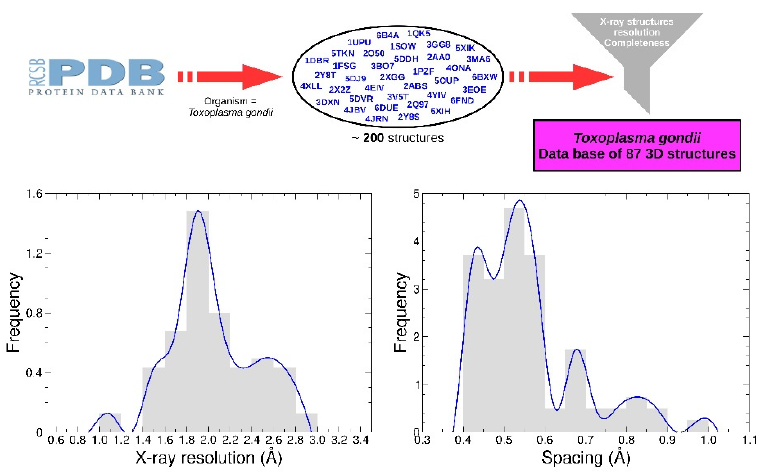
Figure 7. T. gondii protein selection methodology. Protein structures were obtained from the Protein Data Bank. About 200 structures of T. gondii proteins were selected and then filtered according to their acquisition method (X-ray), resolution (less than 3 angstroms), and completeness. The final dataset contains 87 structures whose resolution (graph on the left) and spacing (graph on the right) distribution are presented.